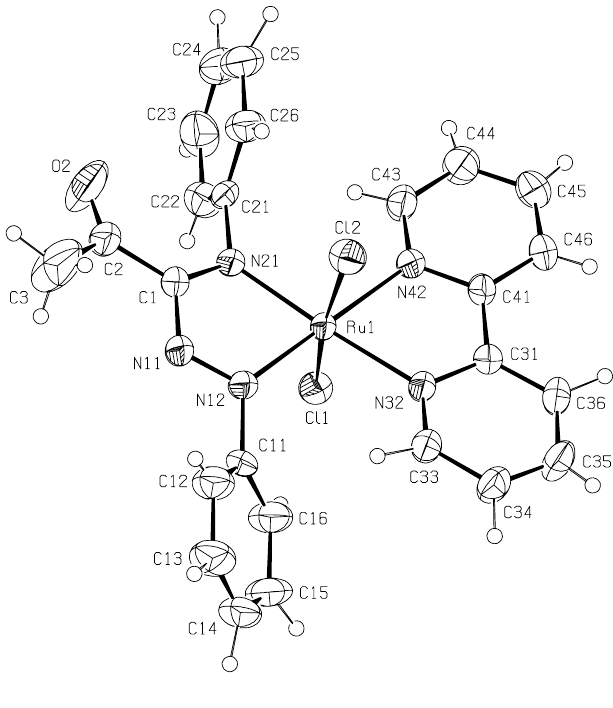
Table 1. Data collection and handling.